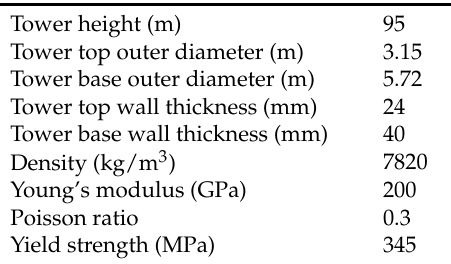
Table 3. Geometric and material properties of the